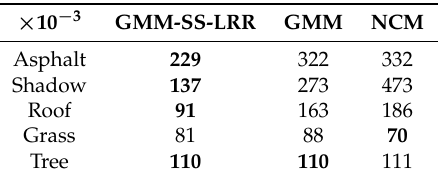
Table 4. The RMSE calculated between the probability value in each histogram and the estimated value at each bin location for the Gulfport